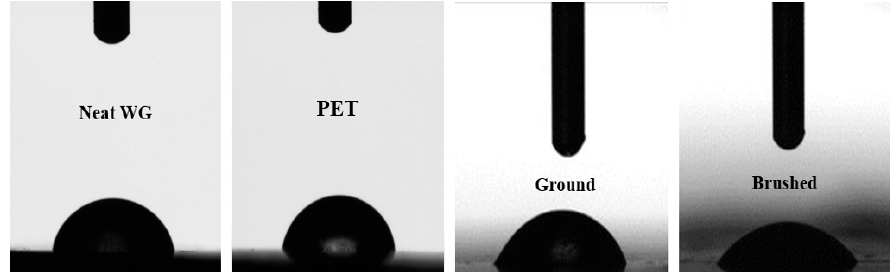
Figure 12. Water droplets on the samples during the goniometer test.